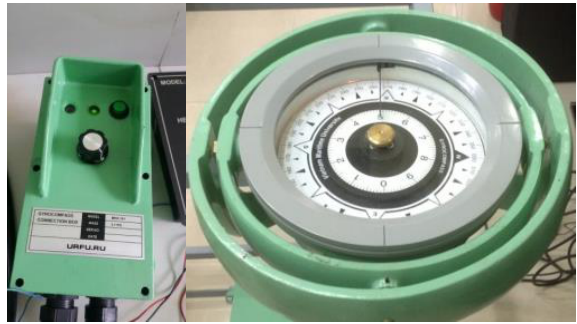
Fig. 4. Gyrocompass Repeater model.